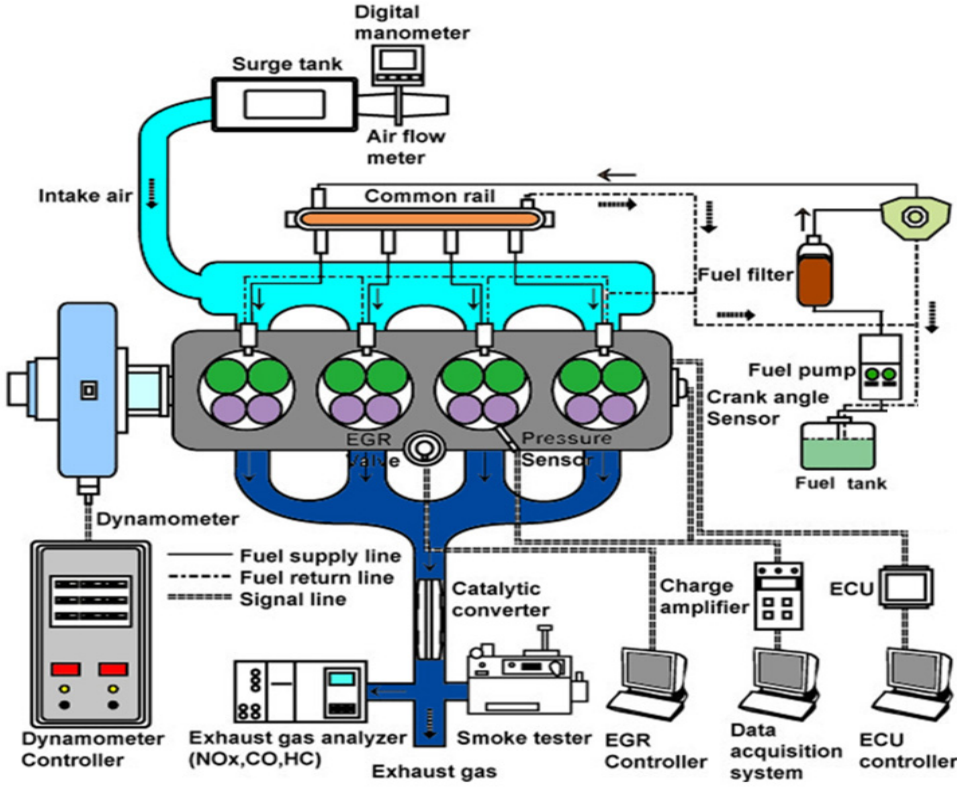
Figure 1. Experimental equipment. Table 2. Detailed specifications of the test engine.